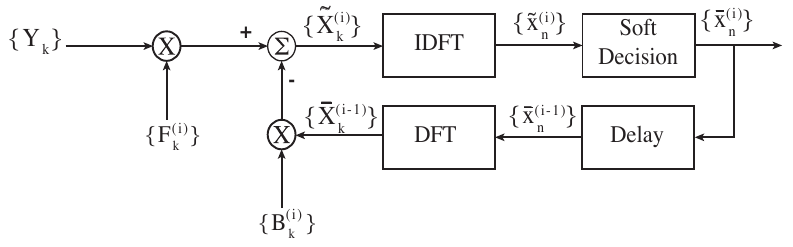
Figure 2. IB-DFE receiver